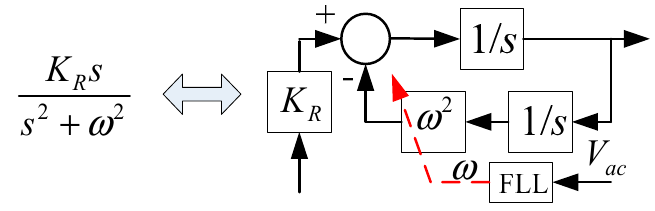
Figure 9. Self-adaptive frequency control.